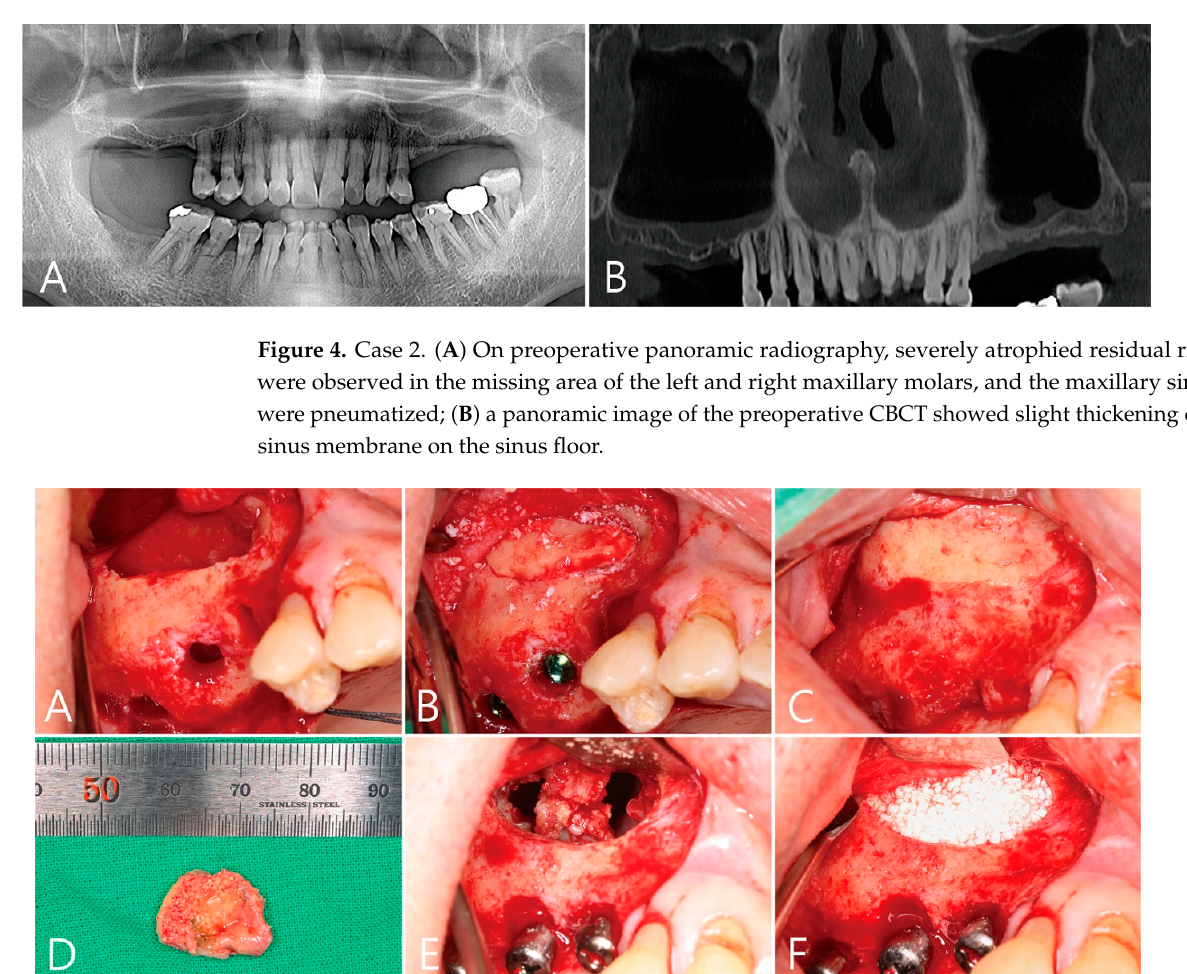
Figure 5. ( A ) After flap reflection, the lateral bone window was removed and sinus floor elevation was performed. There was no perforation of the maxillary sinus mucosa. Three osteotomy sites were perparated for implant placement; ( B ) the maxillary sinus was filled with xenograft material and the removed lateral window bone was repositioned. An implant was also placed. The flap was closed without barrier membrane covering; ( C ) the repositioned lateral bone window after 6 months of operation was well integrated with the adjacent native bone; ( D) the previously repositioned lateral window was separated again to access the remaining large grafting void. The shiny appearance of the inner aspect of the removed specimen is the mucous membrane in contact with the grafting void, and to the left is the lateral window bone; ( E ) after the grafting void was removed, some perforation of the maxillary sinus mucosa was observed in the maxillary sinus bone graft; ( F ) after repair with resorbable collagen membrane, synthetic bone graft substitute was filled into the void.